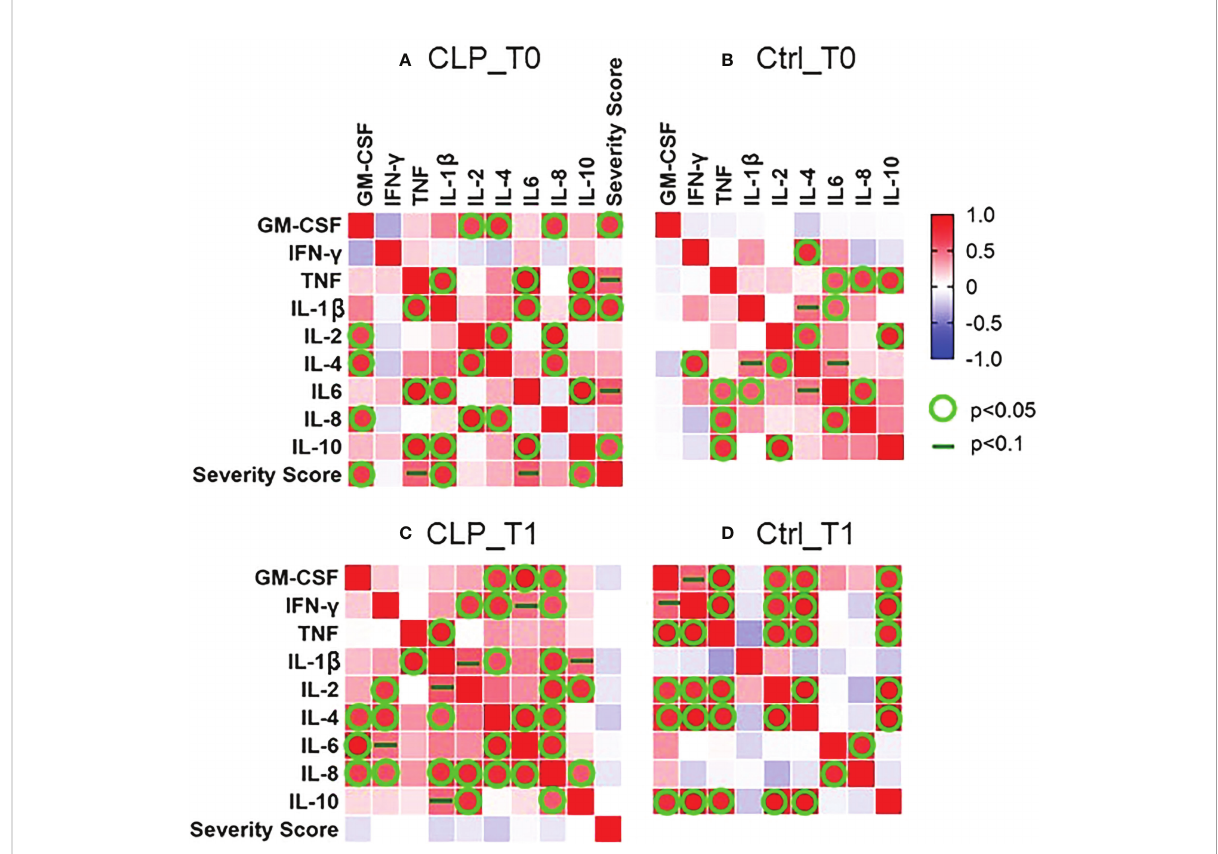
FIGURE 5 Pearson correlation matrix between concentrations (pg/ml) of measured cytokines (Granulocyte-macrophage colony-stimulating factor = GM- CSF, Interferon gamma = INF-y, Tumor-necrosis-factor = TNF, Interkeukin-1ß/-2/-4/-6/-8/-10) and severity score for cleft patients (CLP) compared to controls (Ctrl) at both time points (T0 = after birth, T1 = 4-5 weeks after birth) The heat maps represent the correlation matrix for the CLP group at T0 (A) and T1 (C) and the controls at T0 (B) and T1 (D) . The correlations were calculated between the measured cytokines (GM-CSF, INF-y, TNF, IL-1ß/-2/-4/-6/-8/-10) and the severity score. A color scheme represents the Pearson ’ s r for each combination of variables. Red presents a perfect positive correlation (r = 1) and blue a perfect inverse correlation (r = -1). No correlation (r = 0) is represented with white color. A statistically signi fi cant correlation (p<0.05) is represented by a green circle and a dark green line indicates a tendentially signi fi cant correlation